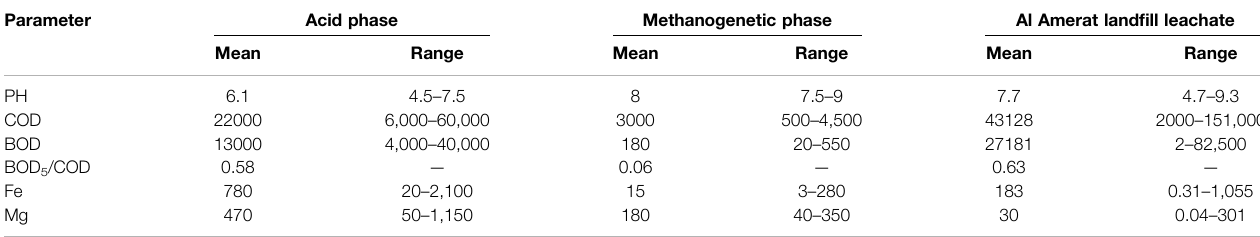
TABLE 3 | Comparison of the parameters in leachate with the land fi ll